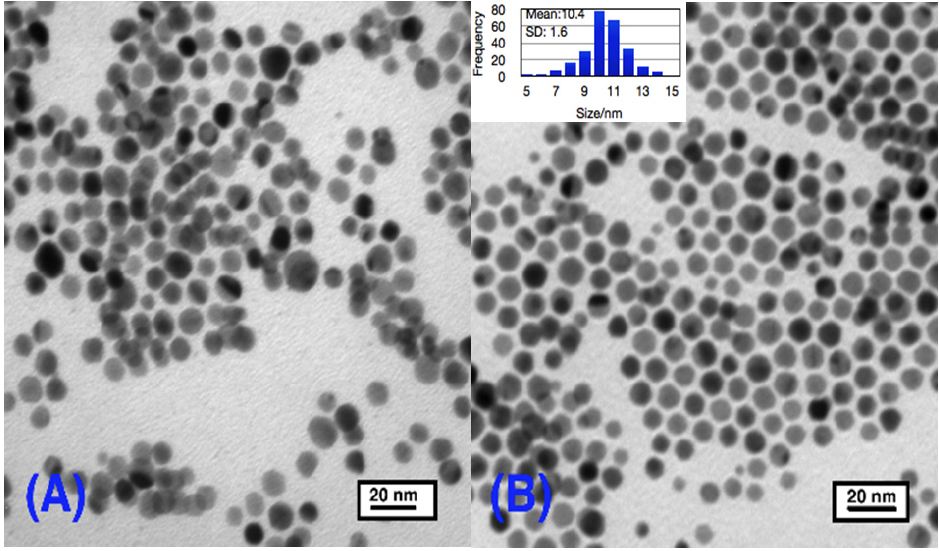
Figure 12. TEM images of ( A ) as prepared Au-octadecylamine colloid in toluene; ( B ) Au-octadecylamine colloid after digestive ripening 2 h in toluene.